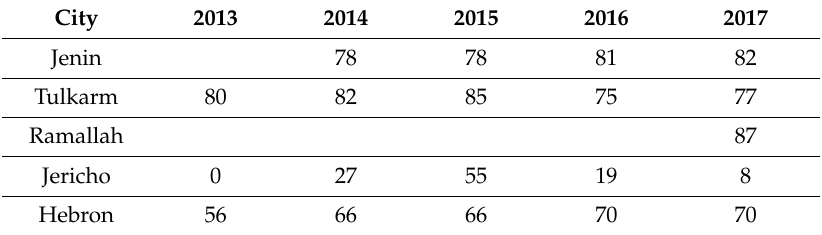
Table 9. Wastewater coverage (WWC) for the period 2013–2017 (%).